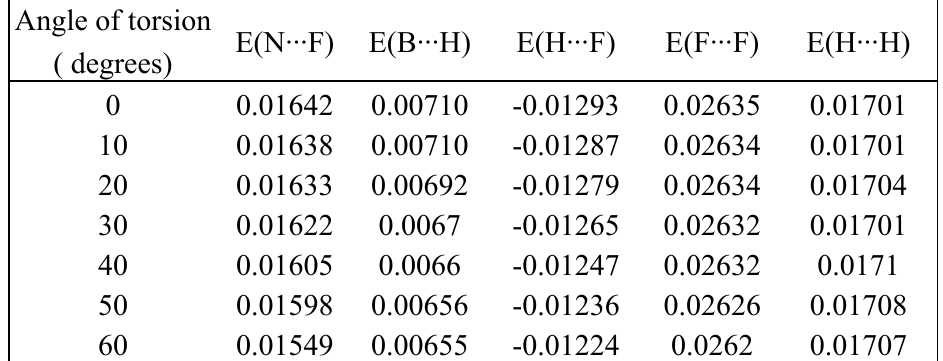
Table 9. Two-center non-bonded interaction energy (a.u.) as a function of torsional angles.